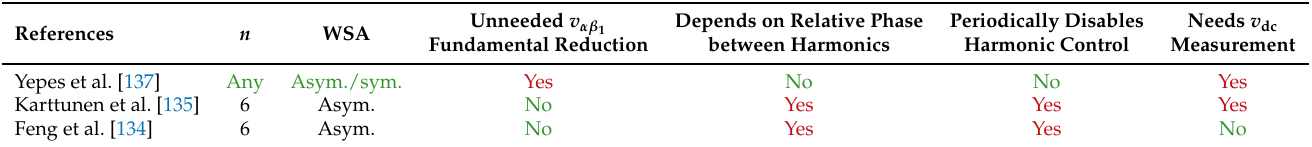
Table 21. Multiphase methods for reducing multifrequency voltage references with partial distur- bance compensation during v dc shortage (Section